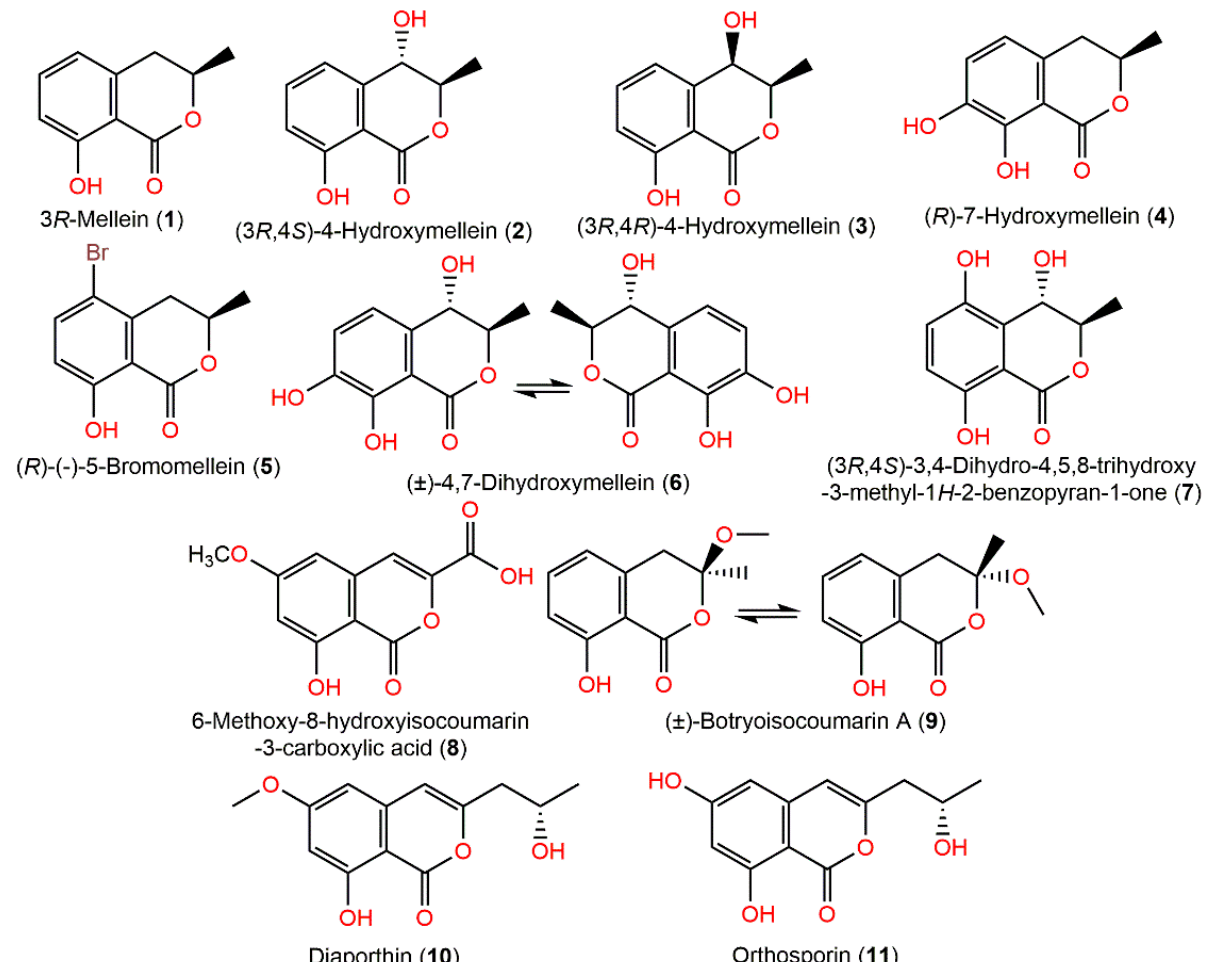
Figure 1. Isocoumarin derivatives ( 1 – 11 ) reported from A. ochraceus.